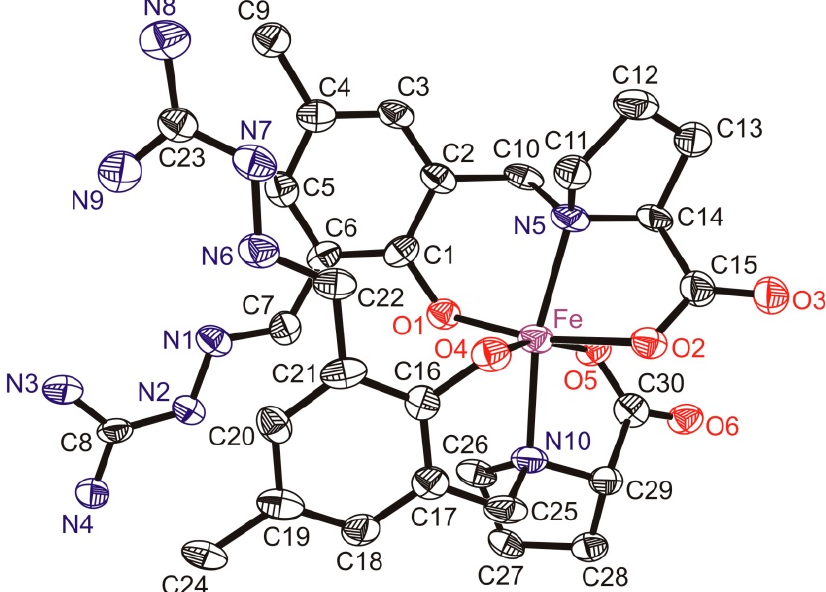
Figure 9. ORTEP view of Na[Fe(III)(Pro-SISC-MeH − 2 ) 2 ](H 2 O) 4 ( 2 ) with thermal ellipsoids at 30% probability level. Water molecules, counter ion (Na + ) and hydrogens are omitted for clarity. Selected bond length (Å) and angles (deg): Fe1-O1: 1.901(9); Fe1-O2: 2.057(9); Fe1-O4: 1.978(9); Fe1-O5: 2.100(9); Fe1-N10: 2.14(1); Fe1-N5: 2.14(1); O1-Fe1-O4: 98.9(4); O4-Fe1-O2: 87.1(4); O1-Fe1-O5: 91.9(4); O2-Fe1-O5: 84.5(4); O1-Fe1-O2: 167.6(4); O4-Fe1-O5: 164.5(4); N5-Fe1-N10: 164.2(5).